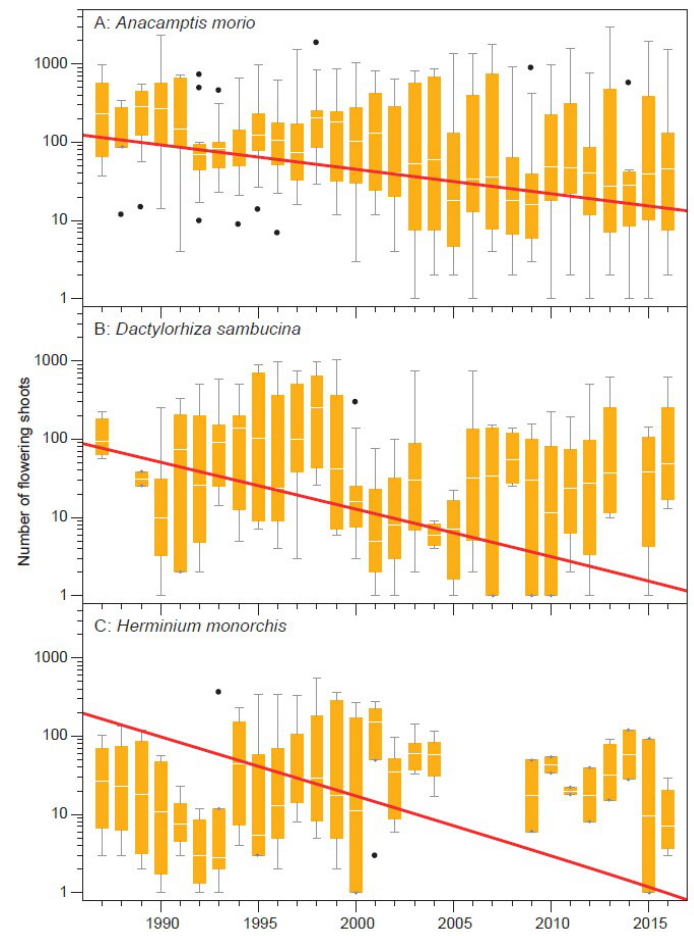
Figure 3. The observed number of flowering shoot changes for three orchid species shown as box plots of the mean site abundance (white line: medians, yellow box: 25–75%, whiskers: 2.5–97.5%, points: outliers), where the red line illustrates the estimated annual change in the linear model (2). The shown box plots are a summary of the hierarchical repeated-measure abundance data and cannot be eyeball-fitted to the back-transformed median slope. ( A ) Anacamptis morio , ( B ) Dactylorhiza sambucina , ( C ) Herminium monorchis .